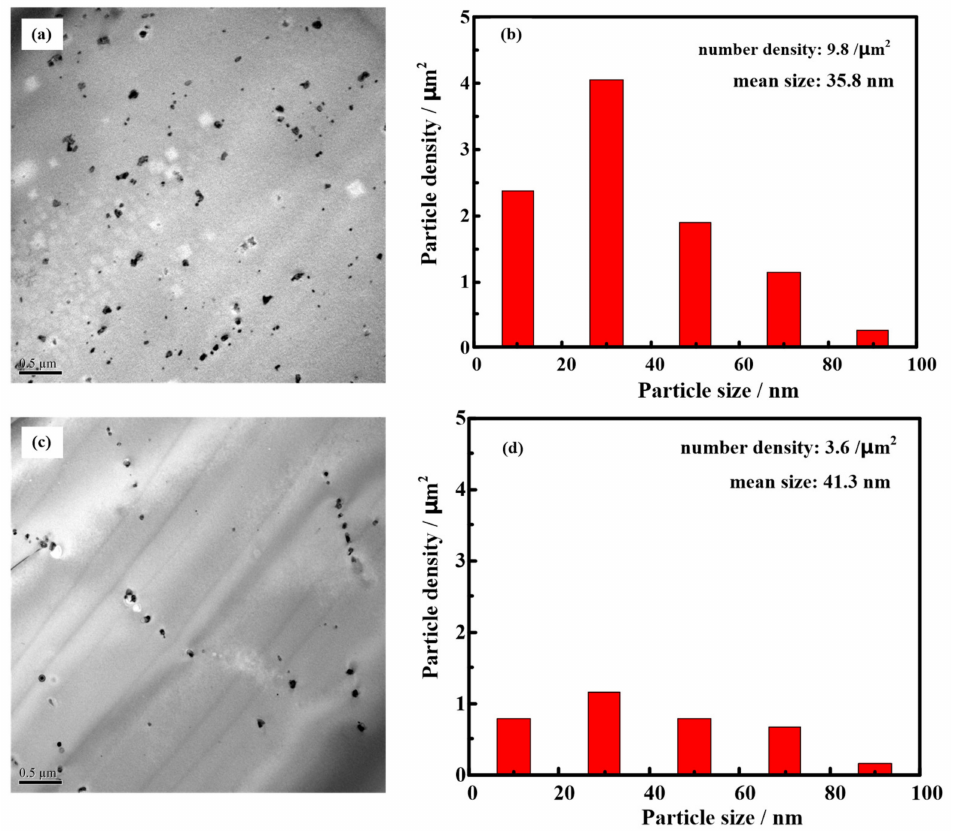
Figure 7. TEM micrographs ( a , c ) and statistical results ( b , d ) of precipitates in the primary annealed sheets produced by conventional ( a , b ) and twin-roll casting ( c , d )